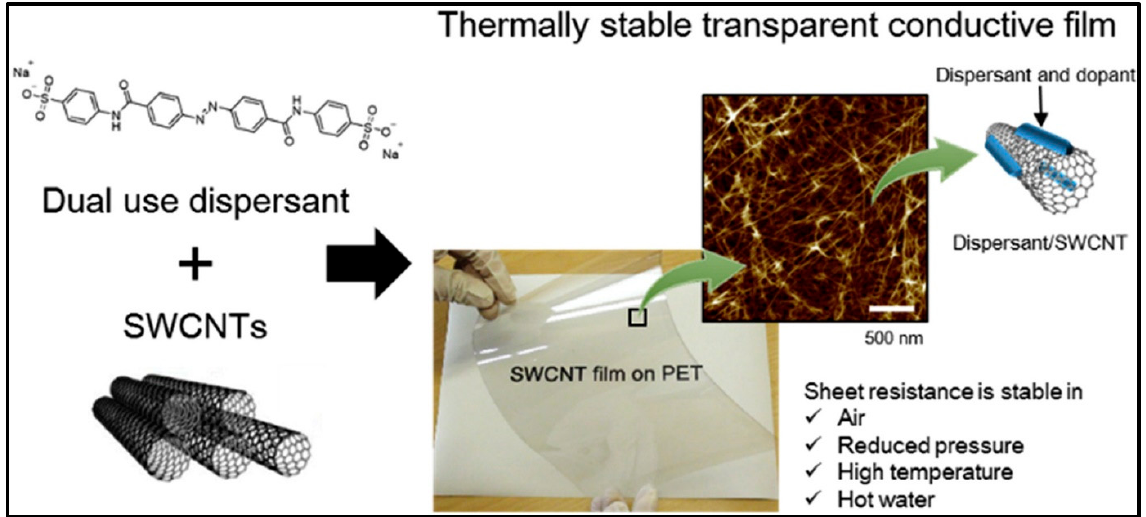
Figure 15. Dual use of anionic AZO derivative as dispersant and dopant for carbon nanotubes for enhancing the thermal stability of transparent conductive films [144].